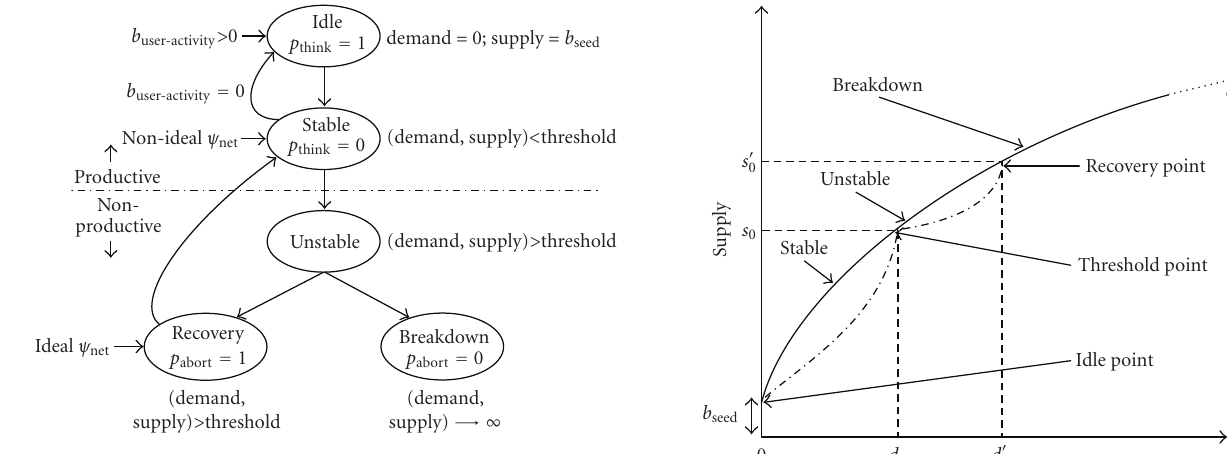
Figure 3: Remote microscopy system state transitions.